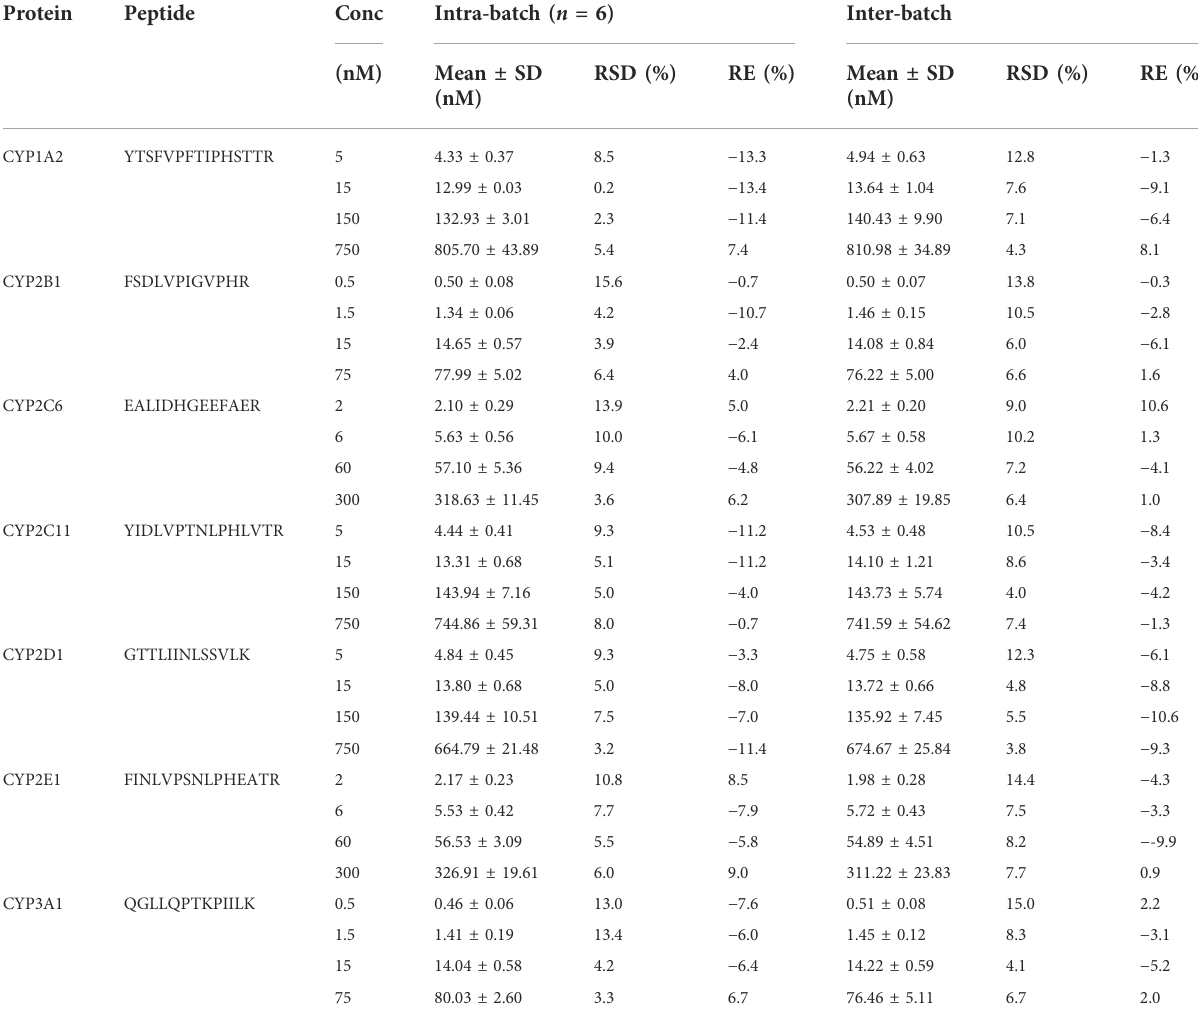
TABLE 2 The intra- and inter-batch precision and accuracy of QC samples for surrogate peptides. The results of three analysis batches were used for inter-batch calculation. RSD, relative standard deviation; RE, relative error. Protein Peptide Conc Intra-batch ( n = 6)